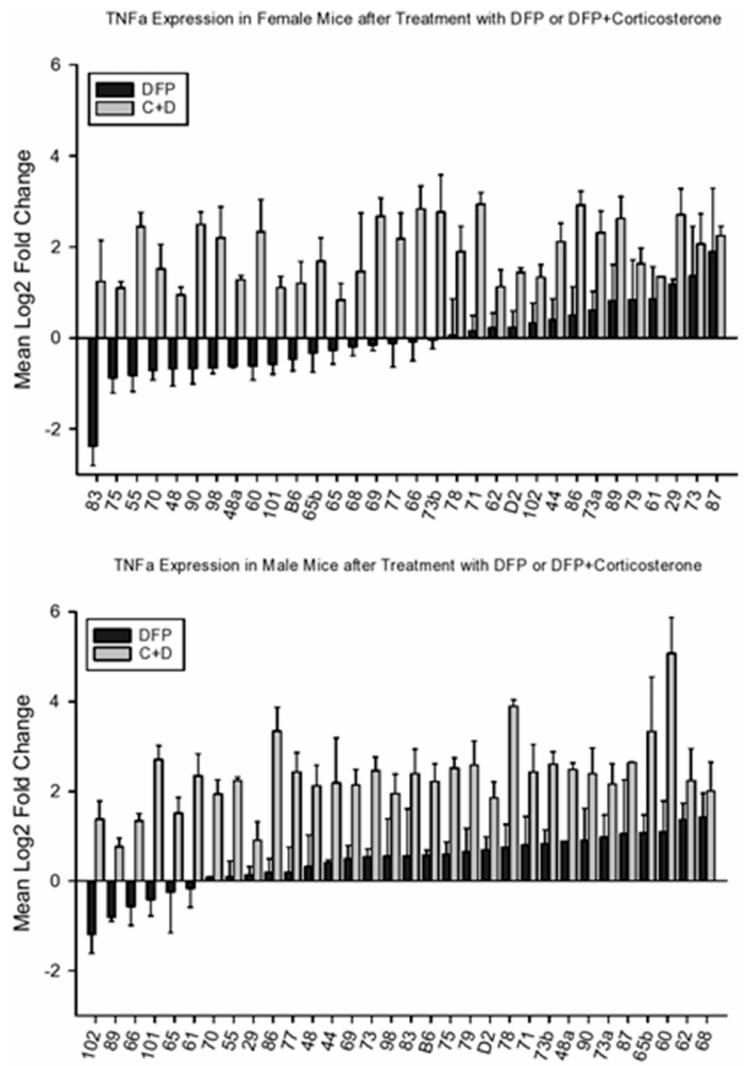
Figure 7. Mean change ( ± s.e.m) vs. control in Tnfa expression in prefrontal cortex 6 h following intraperitonealinjectionwithdiisopropylflurophosphate(4mg / kg—blackbars)or7daysofcorticosterone in the drinking water and 6 h following intraperiteoneal injection with diisopropylflurophosphate (gray bars). Top panel, females, bottom panel,